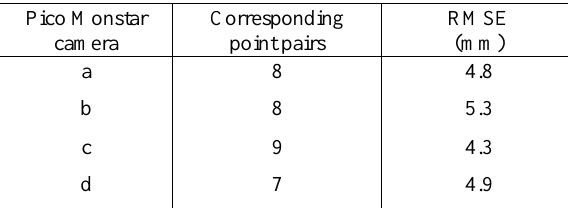
Figure 8. Simulated data collection in the imaging lab.